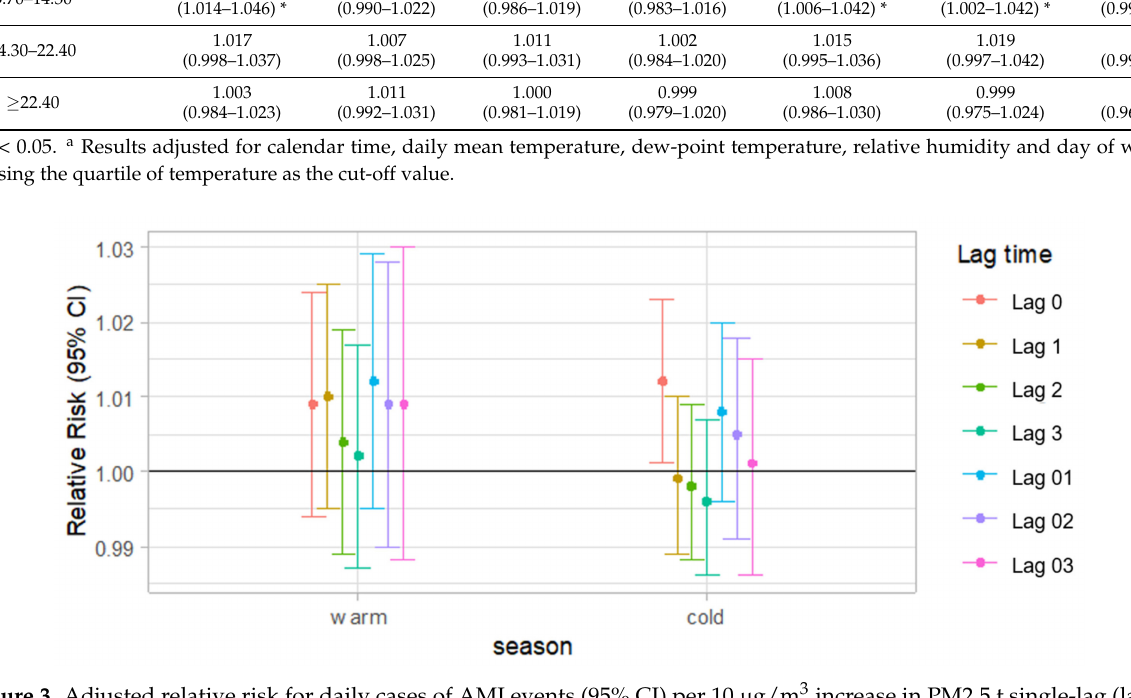
Figure 3. Adjusted relative risk for daily cases of AMI events (95% CI) per 10 µ g/m 3 increase in PM2.5 t single-lag (lag 0, lag 1, lag2 and lag3) and cumulative-lag (lag 01, lag 02 and lag 03) models according to the season a . a Results adjusted for calendar time, daily mean temperature, dew-point temperature, relative humidity and day of the